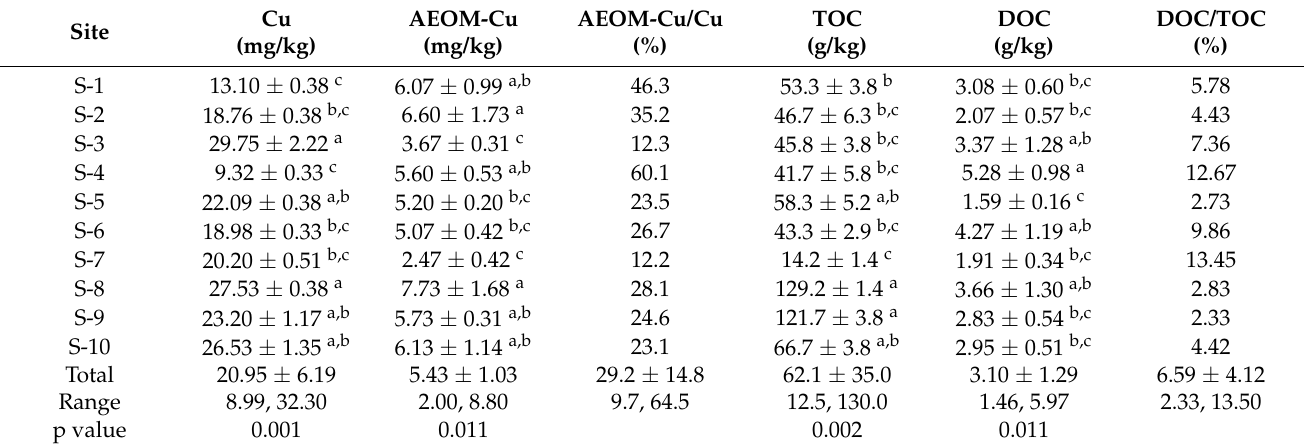
Table 2. The DOC and Cu concentrations of total and extracted bulk AEOM